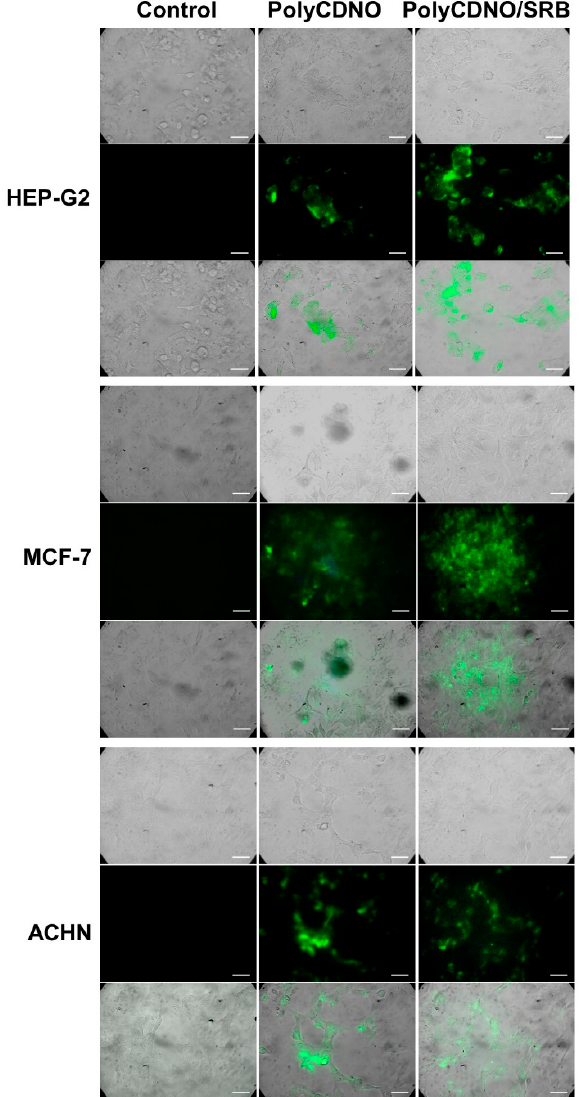
Figure 5. Representative transmission microscopy images ( upper panels ), fluorescence microscopy images collected in the range 500–580 nm and observed upon excitation at λ exc = 488 nm ( central panels ) and merged images ( lower panels ) of different cancer cells incubated for 4 h under different